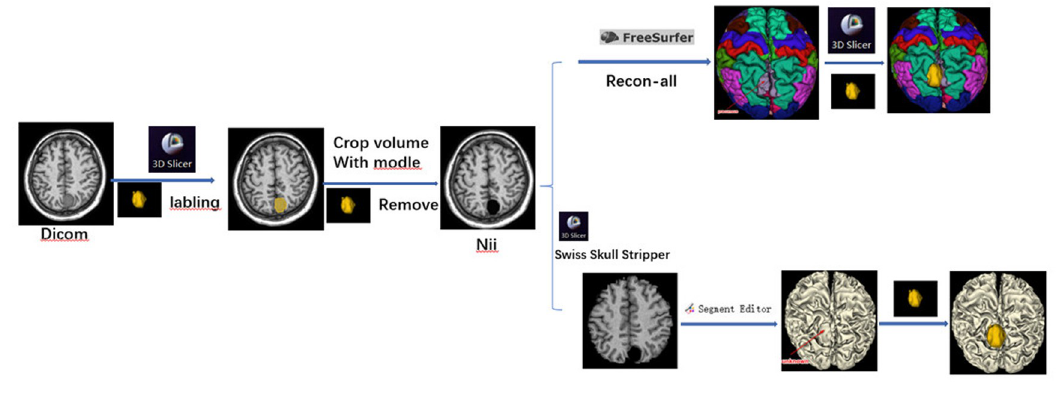
Fig 1. Technology